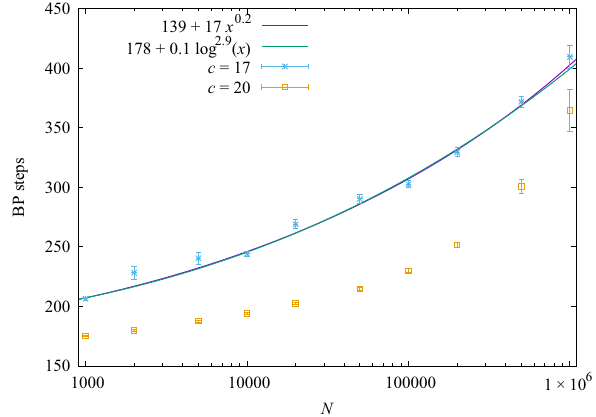
FIG. 13. Number of iterations that the BP algorithm needs before convergence to the planted fixed point as a function of the size of the system N for two values of the connectivities c ¼ 17 and c ¼ 20 . The growth in the number of iterations can be fitted both by a power law t ð N Þ ¼ a þ bN c with a very small exponent c ≃ 0 . 2 , and with a logarithmic growth t ð N Þ ¼ a þ b log c ð N Þ with c ≃ 2 . 9 . The two curves are indistinguishable for the analyzed sizes, and we cannot conclude which is the right scaling.